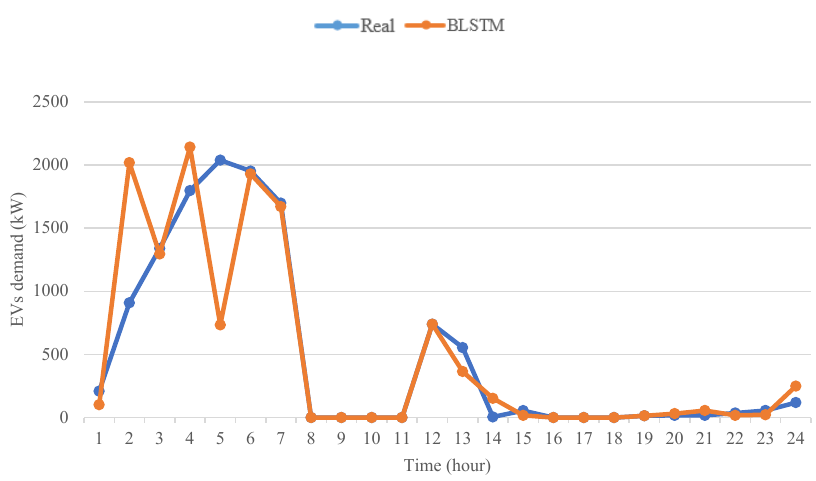
Figure 8. EVs charging in the coordinate charging procedure for real data and BLSTM method.